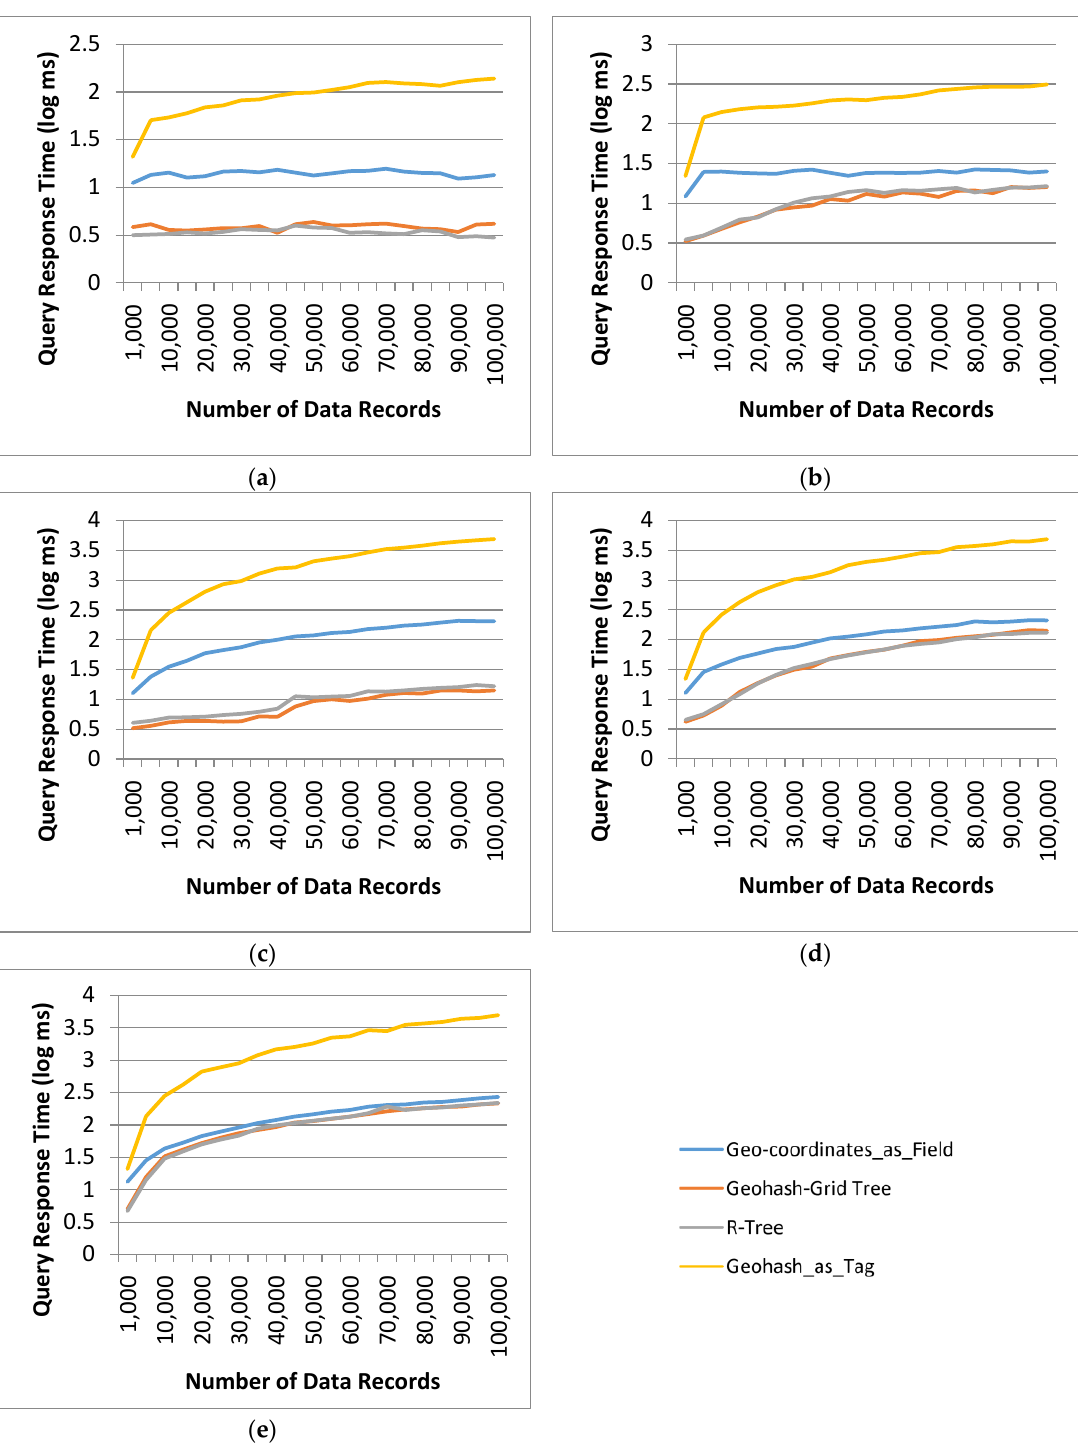
Figure 7. Query Response Time for different methods and selection criteria: ( a ) Query 1; ( b ) Query 2; ( c ) Query 3; ( d ) Query 4; ( e ) Query 5.